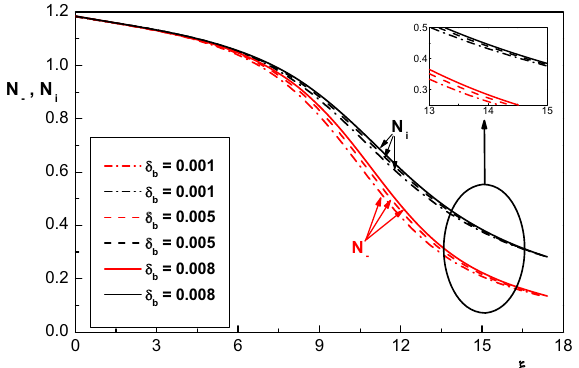
Figure 6. Spatial distribution of the normalized density of positive ions and negatively charged particles for κ c = 2.4 and different values of δ b . The other parameters are the same with Fig. 5.